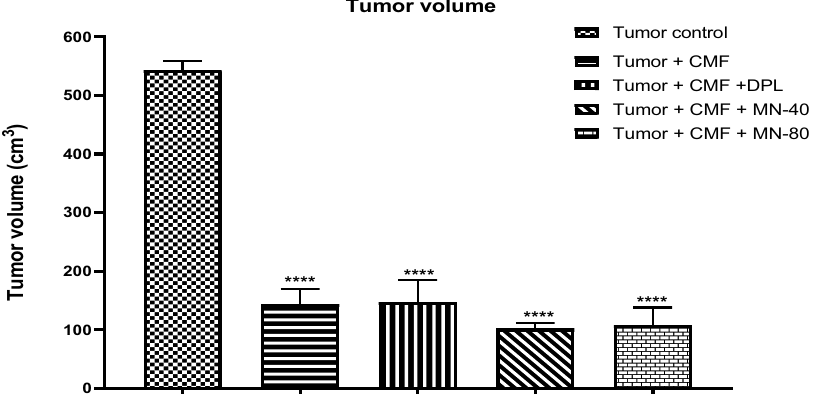
Figure 6. Effect of Mulmina (MN), Cyclophosphamide + Methotrexate + 5-Fluorouracil (CMF), Donepezil (DPL) on tumor volume. Values are expressed as mean ± SEM (n = 3–4). Statistical analysis was done by using one-way ANOVA followed by Dunnet’s post-hoc test. ****p < 0.0001 compared to tumor control